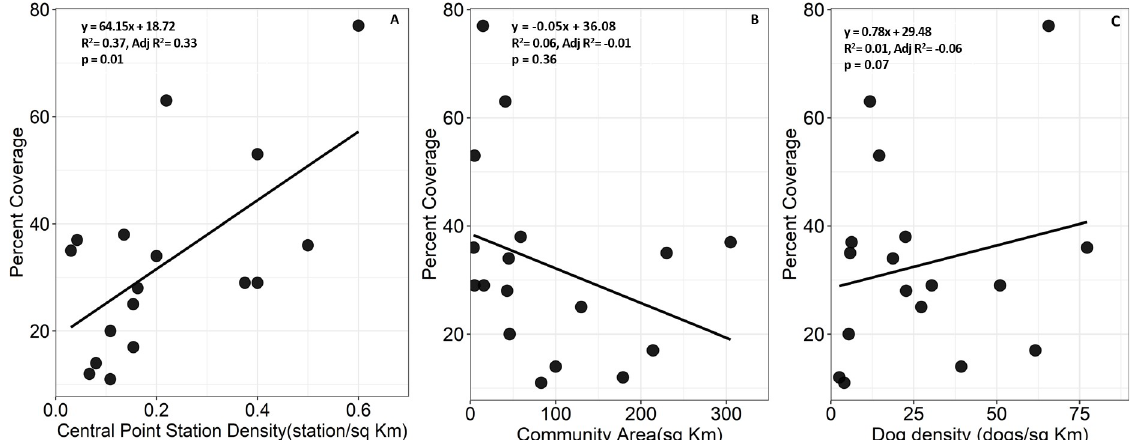
Fig 4. Predictors of percent coverage estimates. Simple linear regressions of percent coverage based on (A) household survey estimates of population sizes only for central point station density, (B) community area in km 2 , and (C) dog density per km 2 for